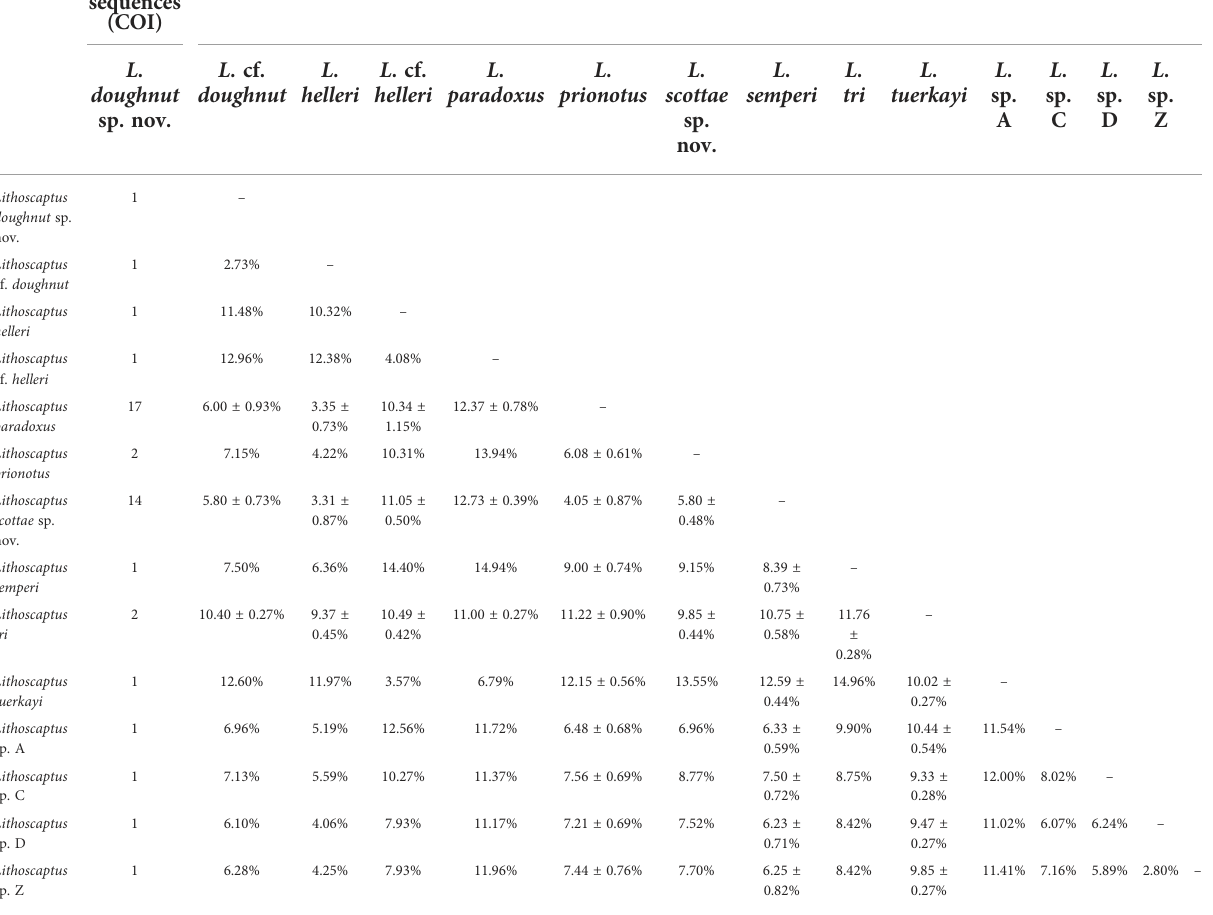
TABLE 3 Matrix of percentage pairwise nucleotide (K2P) divergence between COI sequences within and between groups of recognized Lithoscaptus species. No. of sequences (COI)